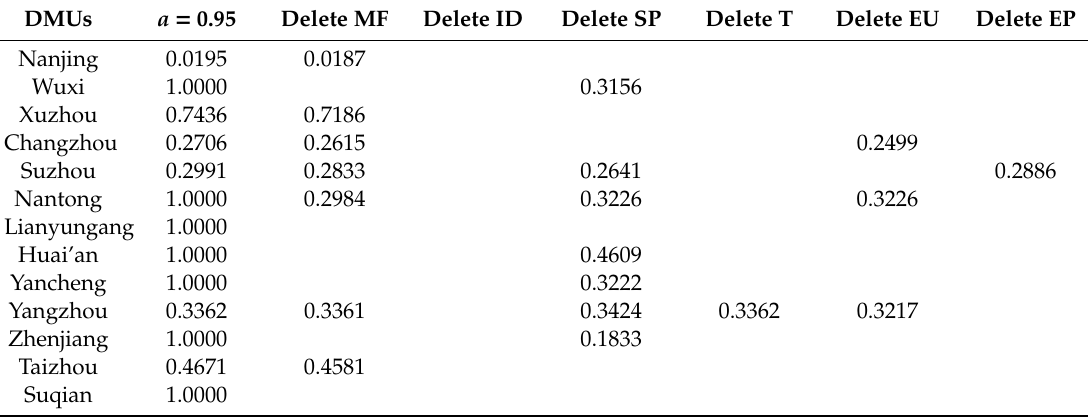
Table A4. The changes of stochastic e ffi ciency value by deleting grouping input variables in 2016 ( α =